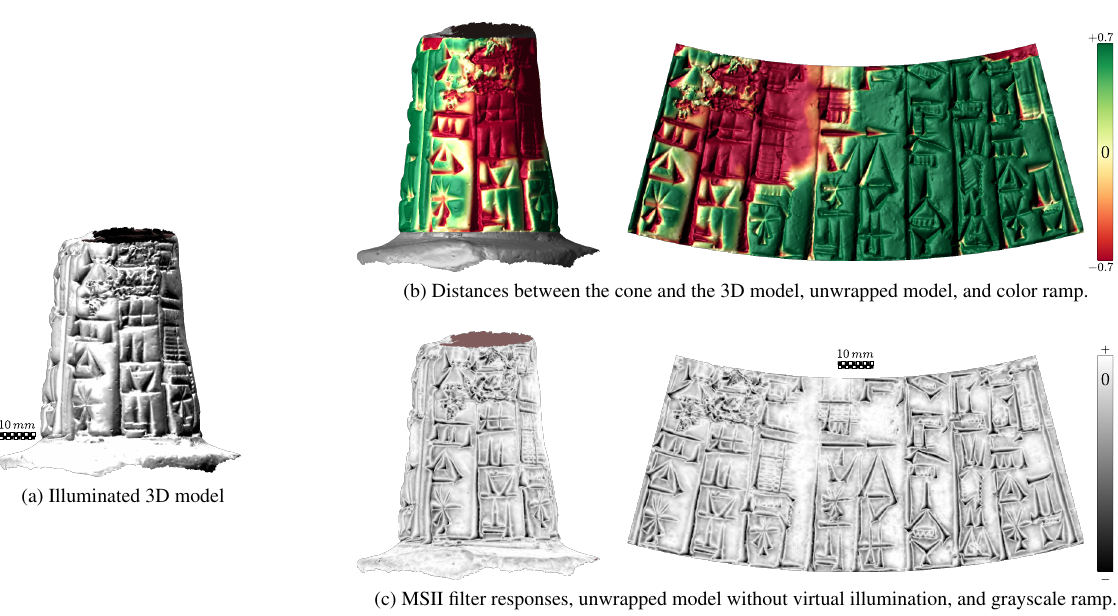
Figure 9: 3D model of a building inscription with cuneiform characters on a Tonnagel (clay cone), ca. 2200 – 2000 B.C., Sammlung des Seminars f¨ur Sprachen und Kulturen des Vorderen Orients, Assyriologie, Universit¨at Heidelberg . For information about the inscription and its known 451 ancient duplicates see (Steible, 1991, Text Ur-Baba 7 ).